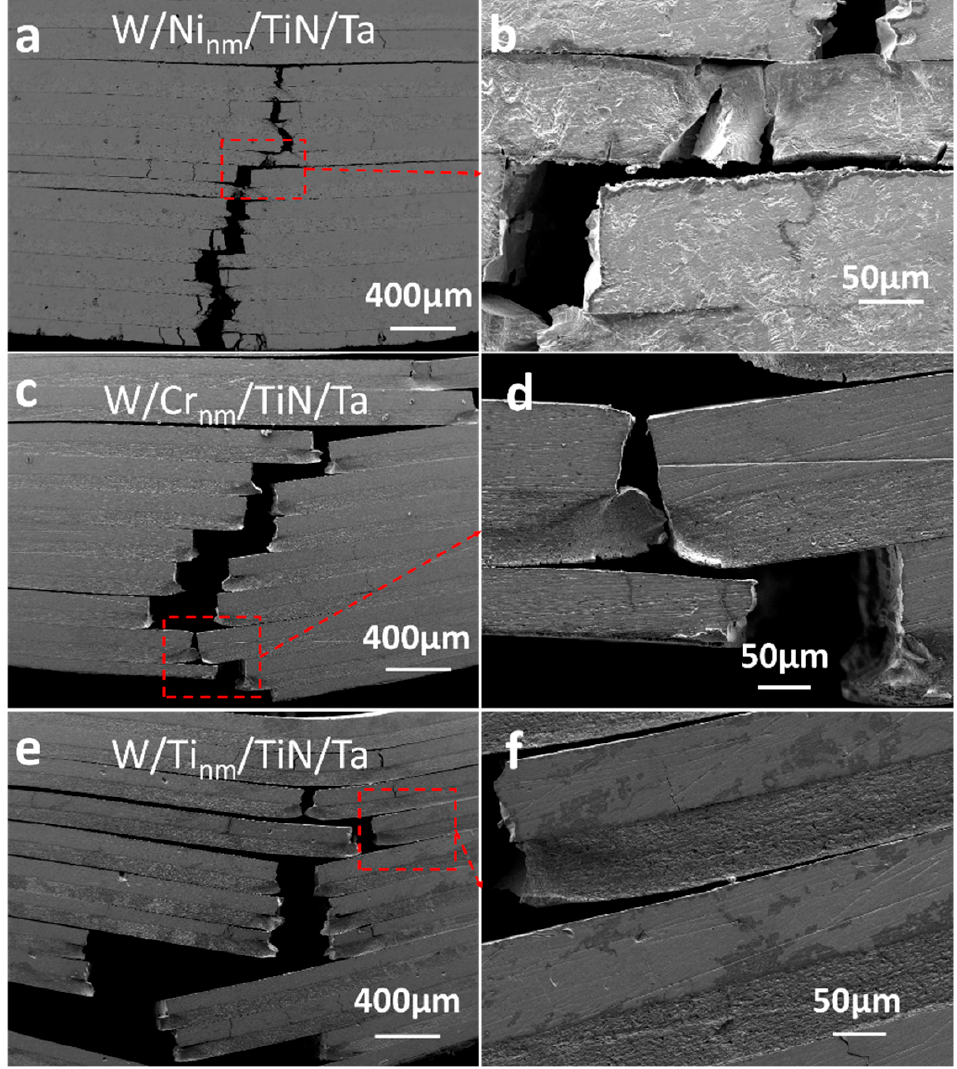
Figure 5. Three-point bending crack distributions of W/M nm /TiN/Ta-laminated composites with different transition metal layers joined at 1400 °C: ( a , b ) W/Ni nm /TiN/Ta, ( c , d ) W/Ti nm /TiN/Ta, and ( e , f ) W/Cr nm /TiN/Ta.